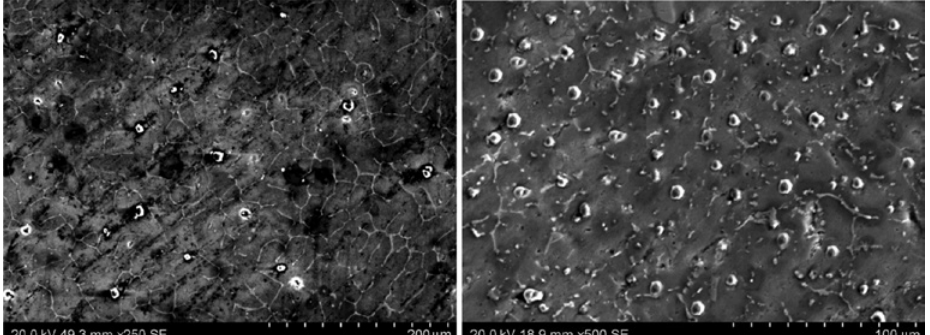
MMC. Reproduced with permission from Elsevier (ScienceDirect) [35]. 2